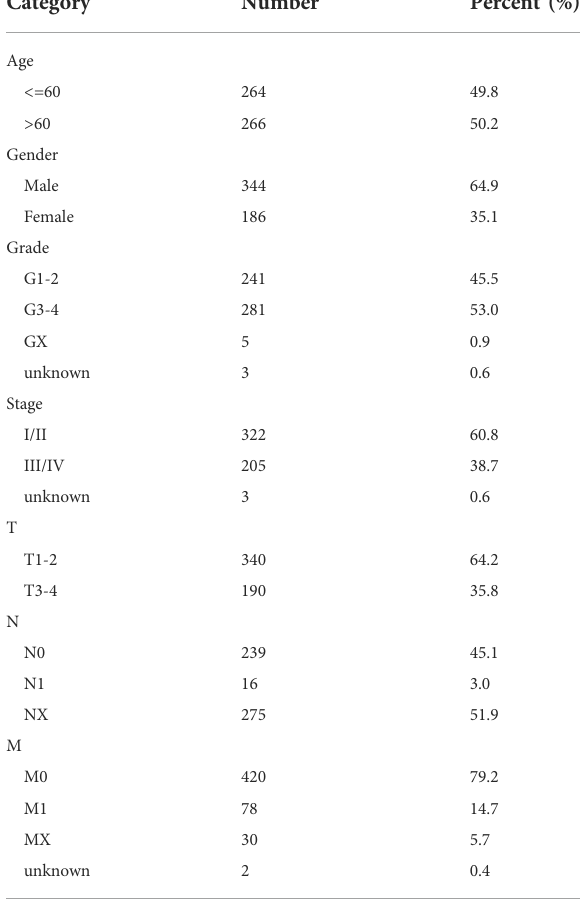
TABLE 1 General characteristic of data source of